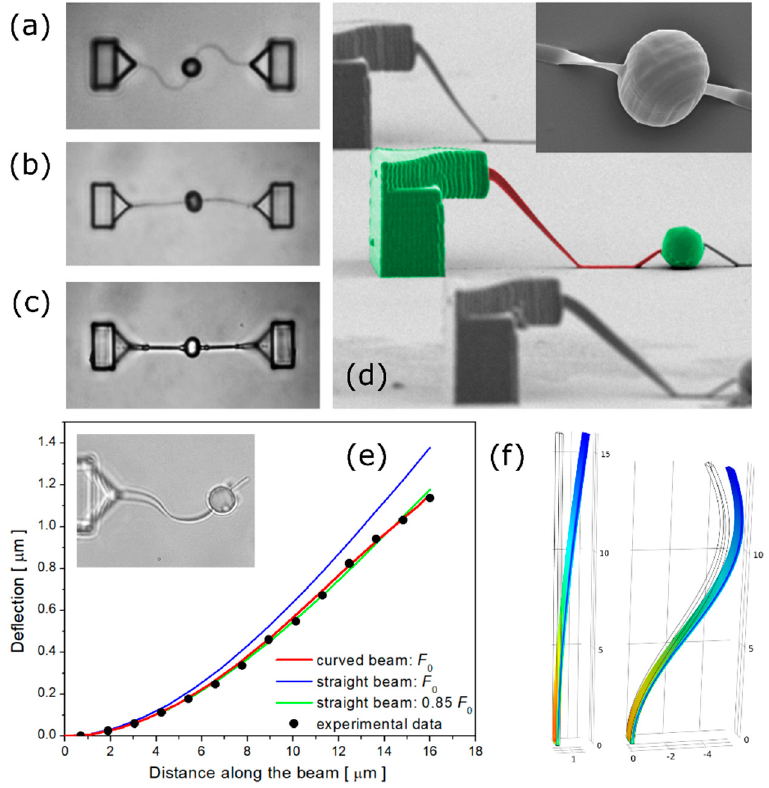
Figure 2. Top-view brightfield images of microstructures immersed in: ( a ) OrmoDev developer; ( b ) water; ( c ) air. ( d ) Side-view SEM image of the dried microstructures, the inset shows the spherical bead. ( e ) Steady-state deflection of the nanowire plotted against the distance along the cantilever beam. The experimental beam deflection (solid points) is compared with the results of straight and curved beam simulations. Inset: the nanowire with the bead immersed in water. ( f ) Deflection of straight and curved cantilevers simulated by finite element method.